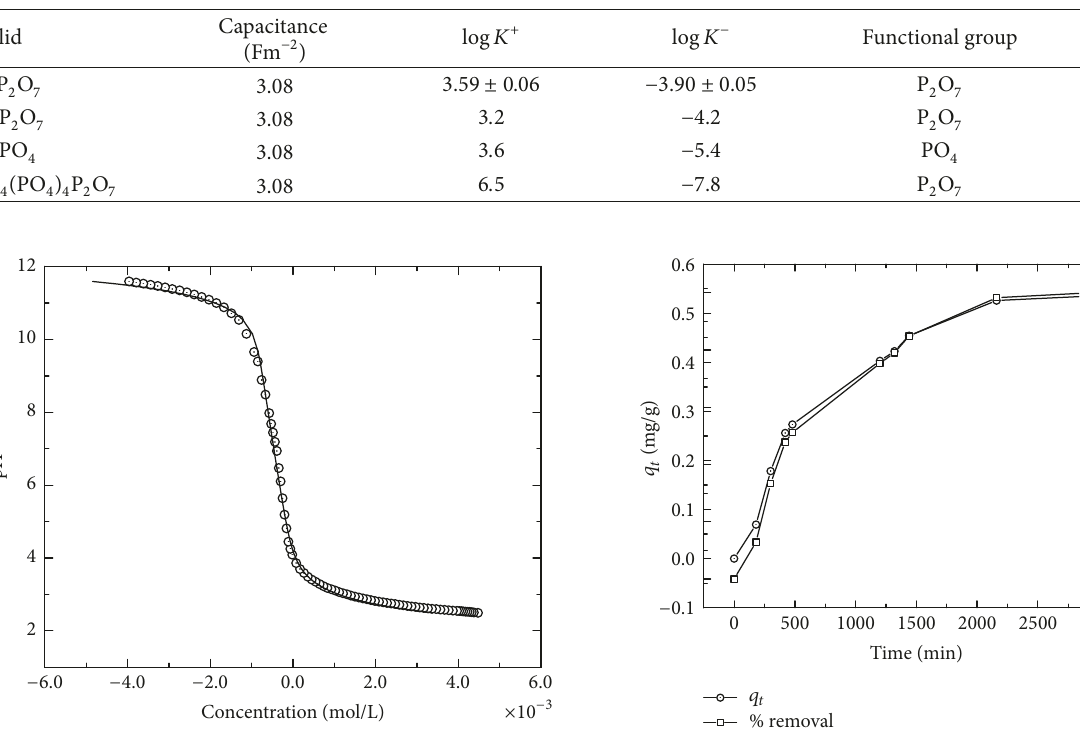
Table 1: Surface acidity constants of titanium pyrophosphate.